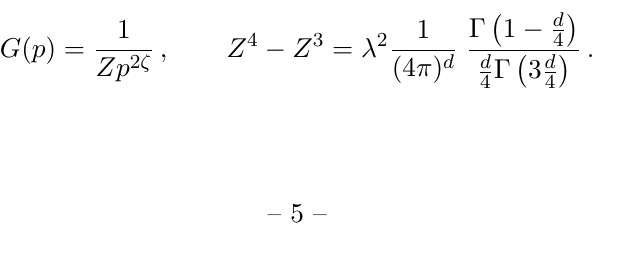
1. We set (cid:16) = d , rendering the 4 (cid:20)